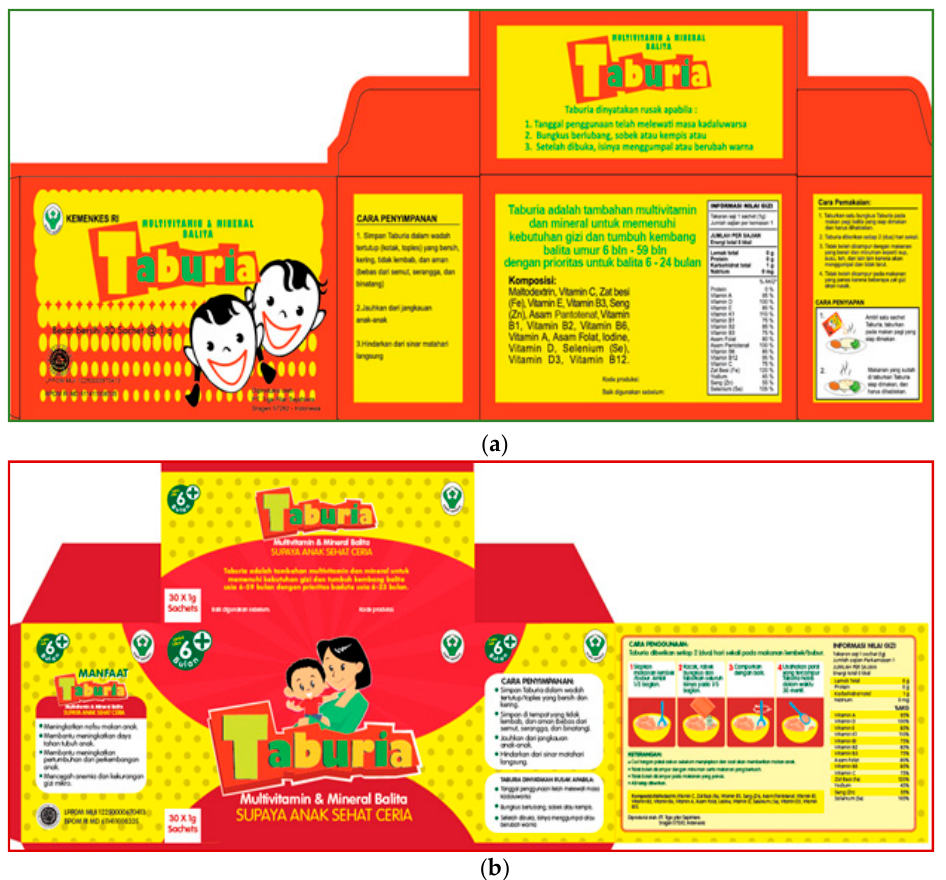
Figure 1. Packaging layout and messages (in Bahasa Indonesian) included in the box of Taburia containing 30 individual 1 g sachets. English translations of the messages are shown in the Supplementary Materials. ( a ) The original packaging approved by the Ministry of Health (MOH), decree number 2409 and enacted June 2011. ( b ) The improved packaging approved by the MOH, decree number 51 and enacted October 2016.